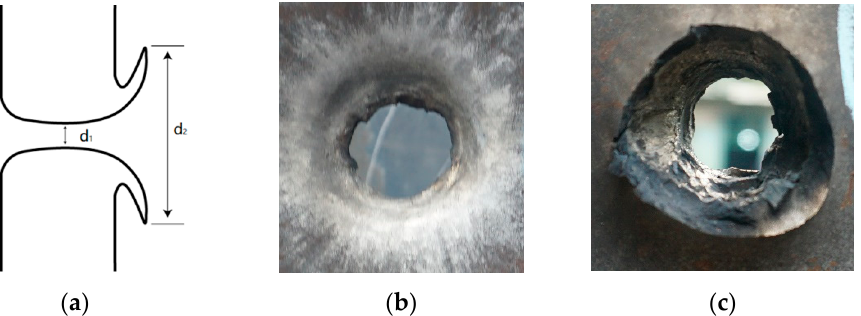
Figure 9. Bullet holes in steel target plates: ( a ) schematic diagram of bullet hole, ( b ) front of target plate, and ( c ) back of target plate.